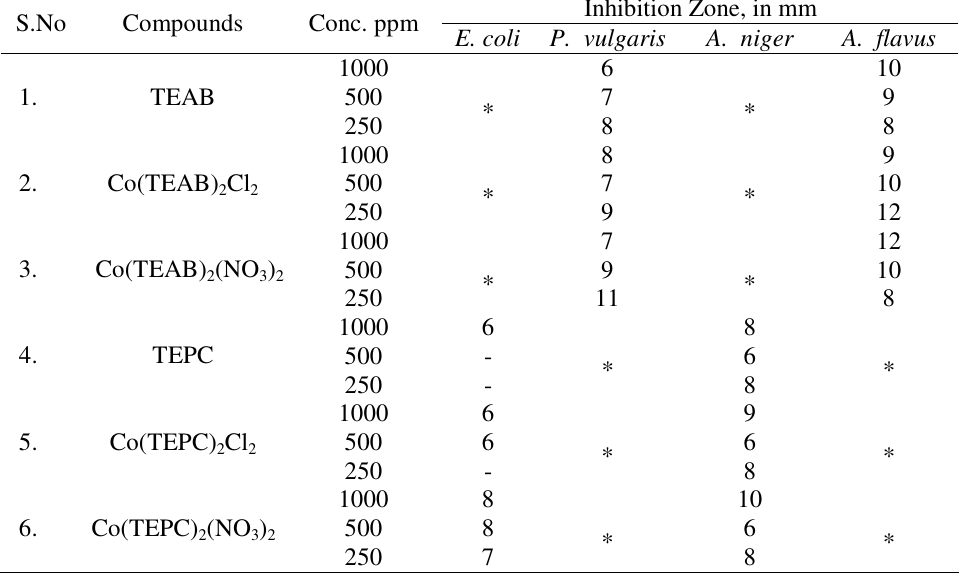
Table 3. Antimicrobial data of synthesized compounds